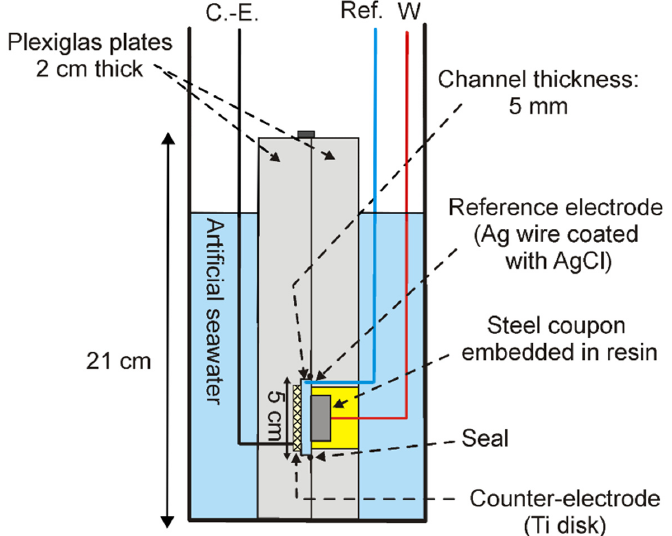
Figure 1. Schematic view (front) of the experimental device showing the respective positions of the steel coupon (grey rectangle) embedded in resin (in yellow), the Ag/AgCl microelectrode (in blue) and the Ti disk used as counter-electrode (hatched rectangle). C.-E., Ref. and W denote the three connections to the potentiostat.